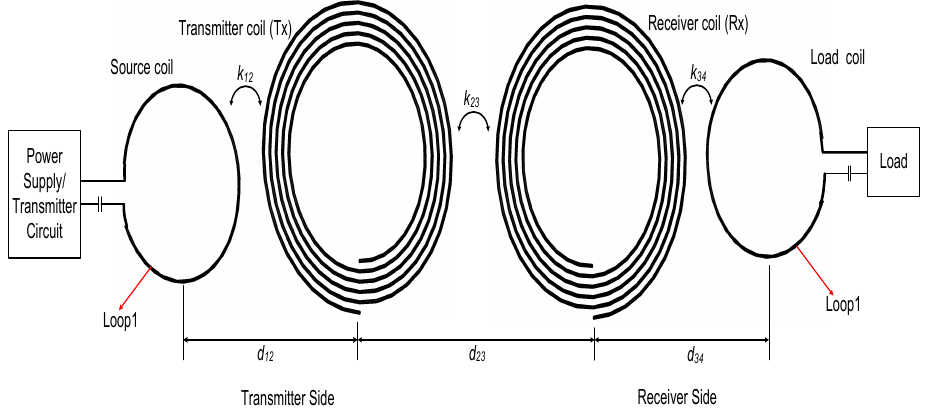
Figure 1. Magnetic resonance-coupled wireless power transmission (WPT)